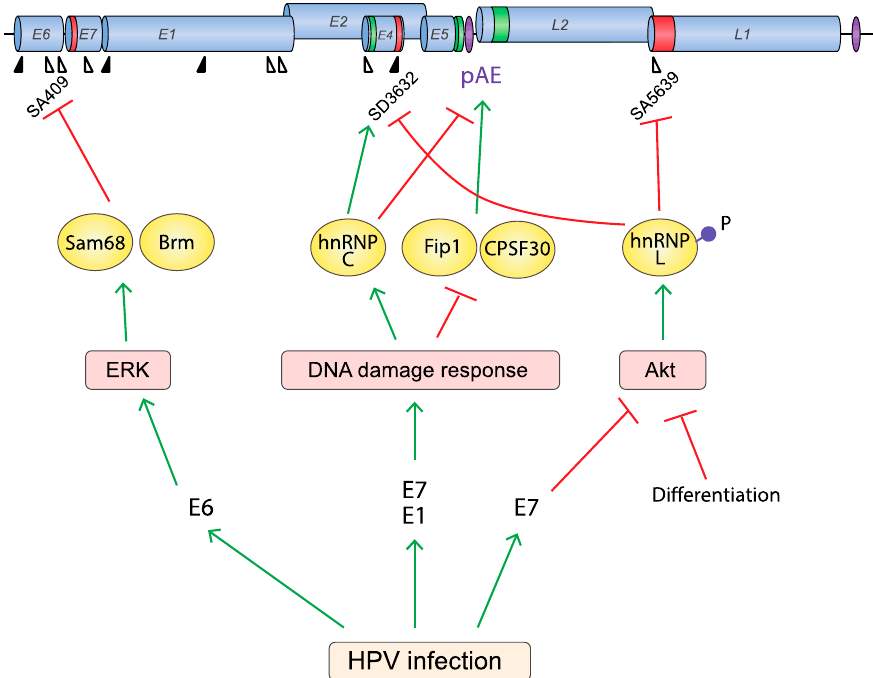
Figure 8. Proteins that regulate HPV RNA processing are controlled by extracellular stimuli and cellular responses. HPV activates the DNA damage response (DDR), the Akt signaling pathway and the ERK signaling pathways upon infection. These activations may a ff ect HPV RNA processing in di ff erent ways. The DDR is activated by HPV E1 and E7 by an unknown mechanism to replicate the HPV DNA in di ff erentiating cells [28]. DDR activation also a ff ects HPV mRNA processing by (1) dissociating Fip1 and CPSF30 from HPV16 early UTR, (2) inducing hnRNP C binding to the HPV16 early UTR, thereby alleviating suppression of HPV16 late splice site SD3632 and reducing the activity of HPV16 pAE. As a consequence, the activation of the DDR induces HPV16 late gene expression [73]. The activity of Akt is restricted to epithelial basal cells and Akt is inactivated during epithelial cell di ff erentiation [199] or HPV E7 expression [202], but is often overexpressed in cervical cancer [200]. Inactivation of Akt reduces hnRNP L phosphorylation, which alleviates the silencing of HPV16 late splice sites SD3632 and SA5639. Thus, inhibition of the Akt kinase activates HPV late gene expression at the level of RNA processing [48]. The ERK signaling pathway is activated by HPV E6 [203], and ERK activity a ff ects HPV RNA splicing by controlling E6 exon inclusion via ERK-responding splicing factors Sam68, Brm, and hnRNP A1